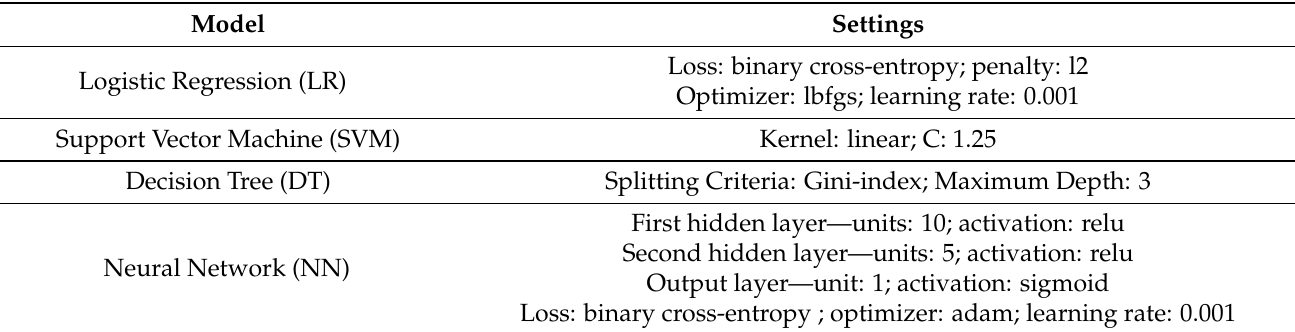
Table 9. Hyperparameters settings of different machine learning models.